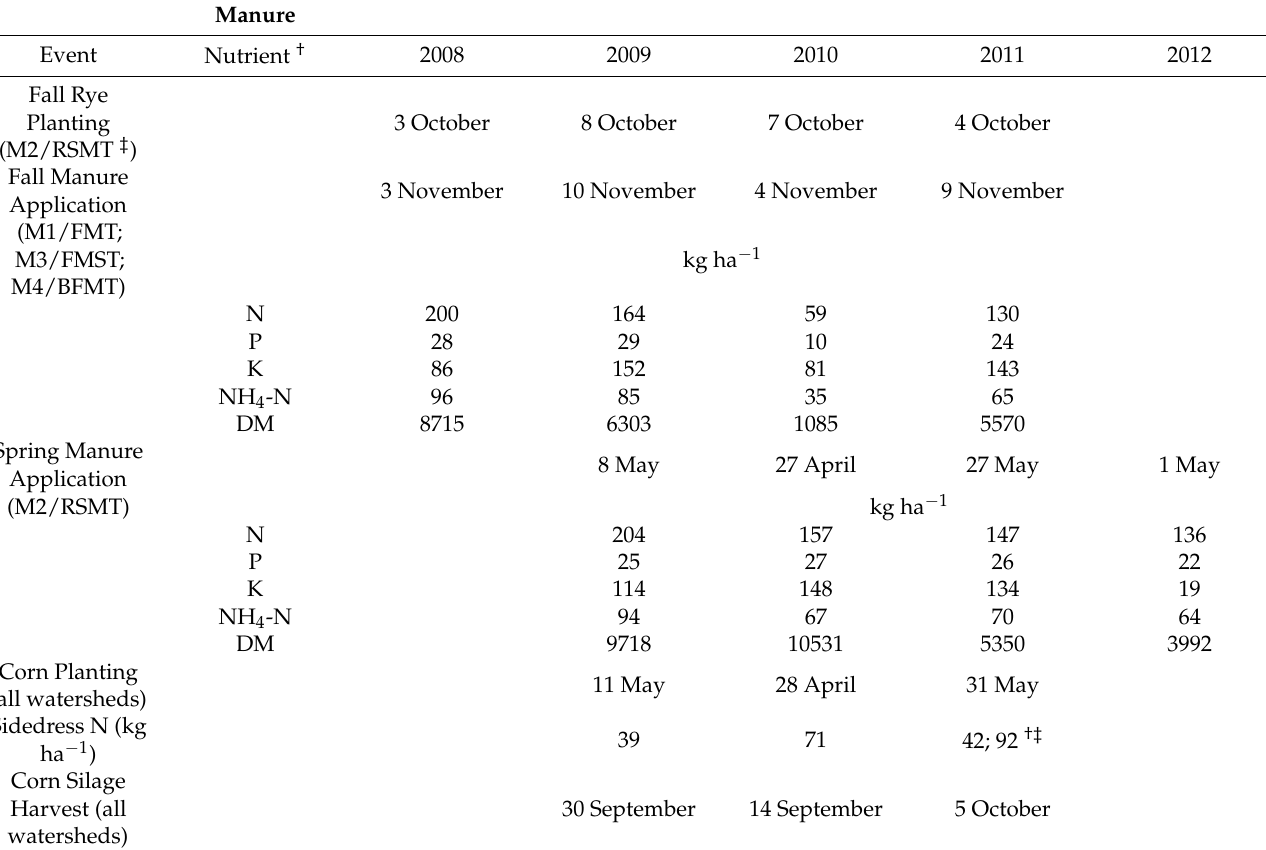
Table 1. Field activities and manure composition during the 2008–2011 treatment period.